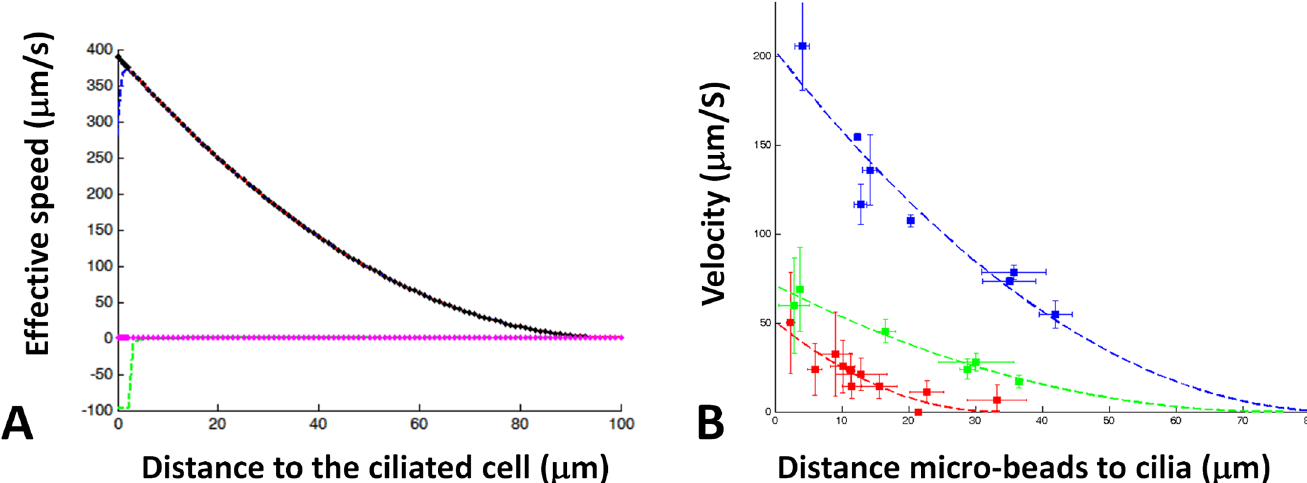
Fig 4. Parabolic velocity profile. (A) Contribution of the different order of the micro-beads velocity The blue dashed line represent the effective velocity (in μ m.s -1 ). Green dashed line represent the contributionof the first order of the fluid velocity. The red dashed line representedthe contributionof the second order. Black points are the contribution of the parabolicterm of the second order. Magentapoints are the contribution of the exponential function. Ciliarybeatingparameters are the following:CBF = 10.0 Hz, CBA = 8.0 μ m, λ = 10 μ m, ϕ = 0 and h = 100 μ m. (B) Examplesof parabolicfitting on microbead velocity measurements on 3 different ciliated edges (see companionpaper